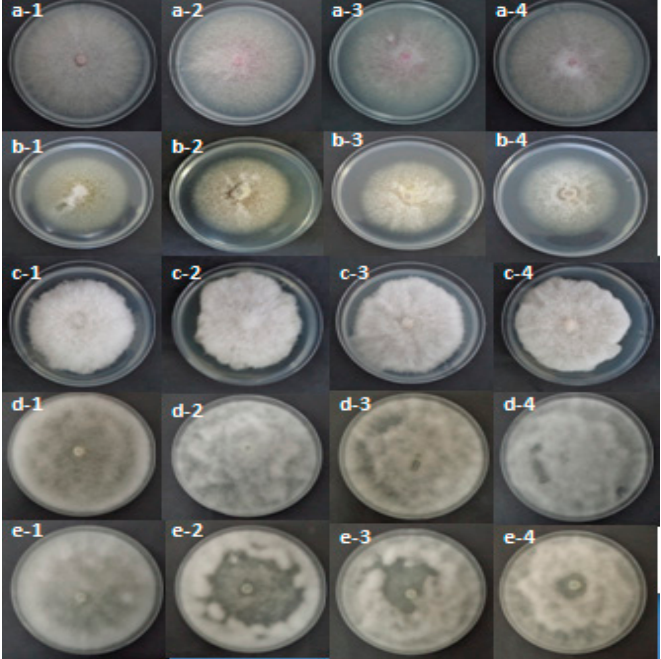
Figure 2. Effect of F1 (2), F12 (3) and F23 (4) fractions of Raphanus raphanistrum ethyl acetate extract on mycelial growth of F. oxysporum ( a ), F. solani ( b ) P. citrophthora ( c ) recorded after six days of incubation and that of Py.ultimum ( d ) and Ph.mercuriale ( e ) noted after two days of incubation at 25 °C in comparison with the control (1).